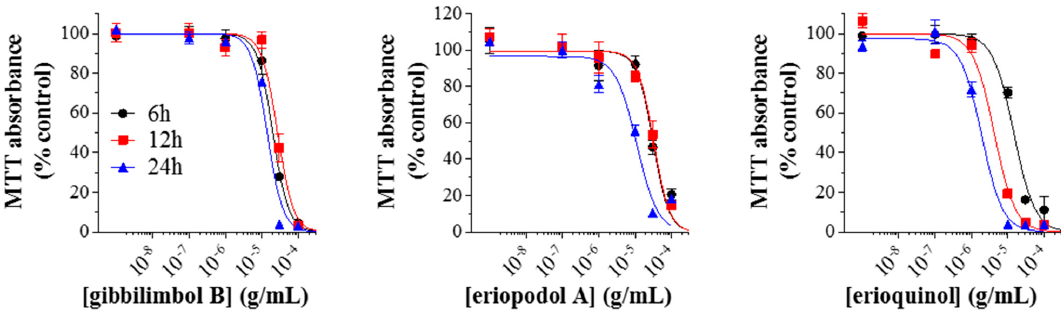
( B ) human umbilical vein endothelial cells (HUVEC) / MCF10 cells were treated with increasing concentrations of gibbilimbol B, eriopodol A, and erioquinol, for 24 h